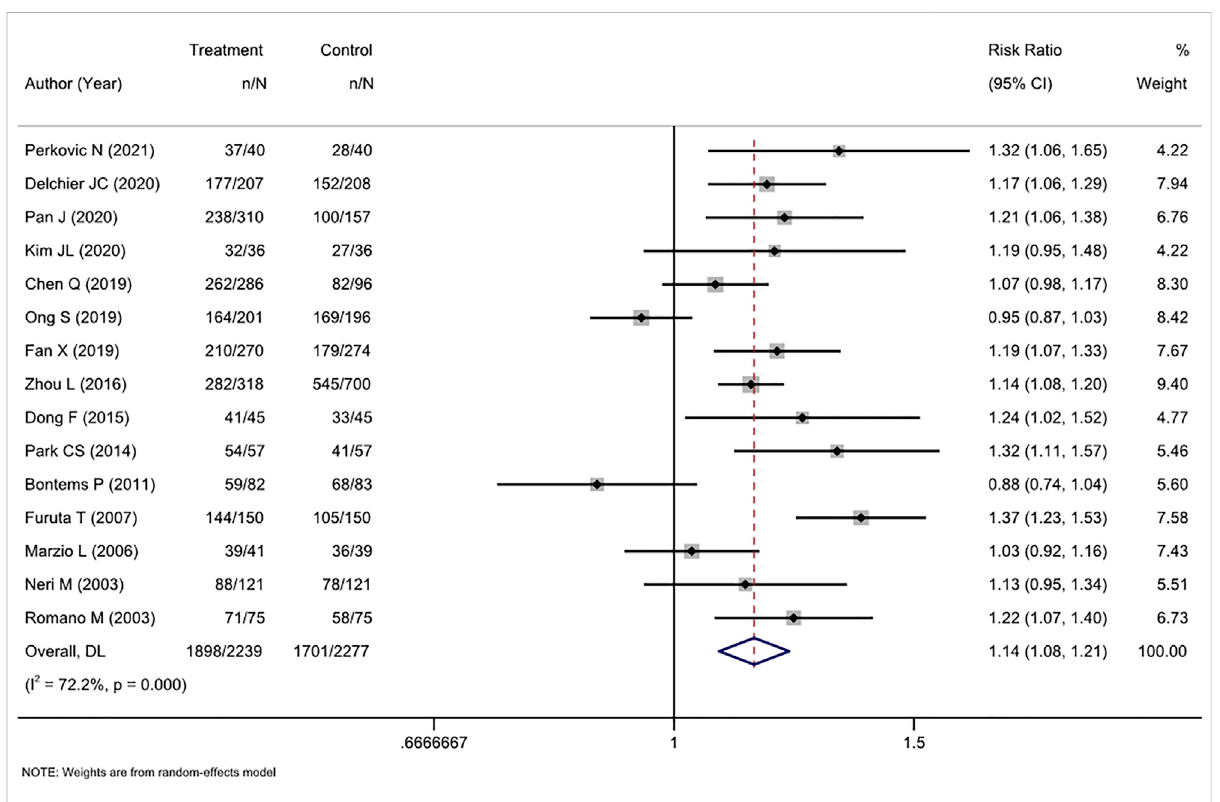
FIGURE 2 Forest plot of the ITT ef fi cacy of RCTs comparing tailored treatment with empirical treatment in the fi rst-line treatment.